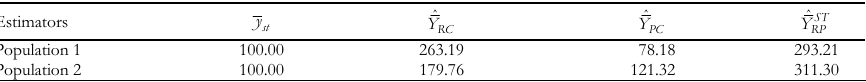
Percent relative efficiencies of